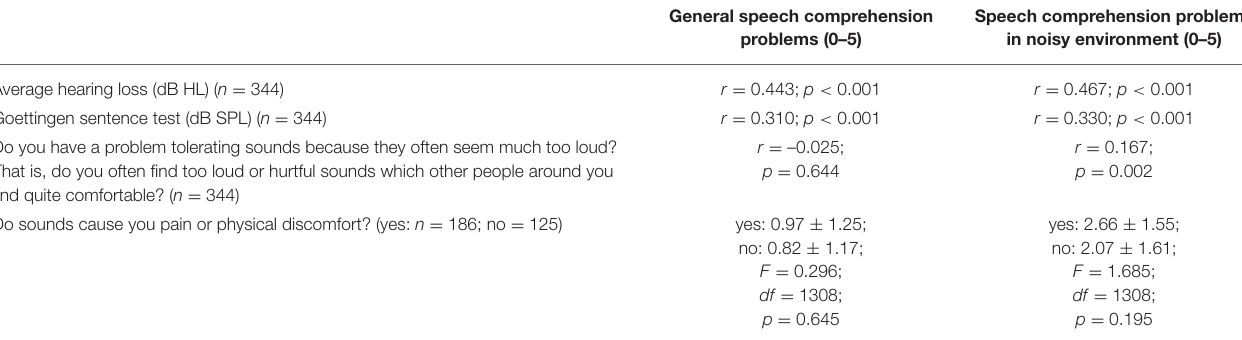
TABLE 1 | (B) Association of variables of audiometry, Goettingen sentence test, and hyperacusis with subjective speech comprehension with the tinnitus questionnaire as